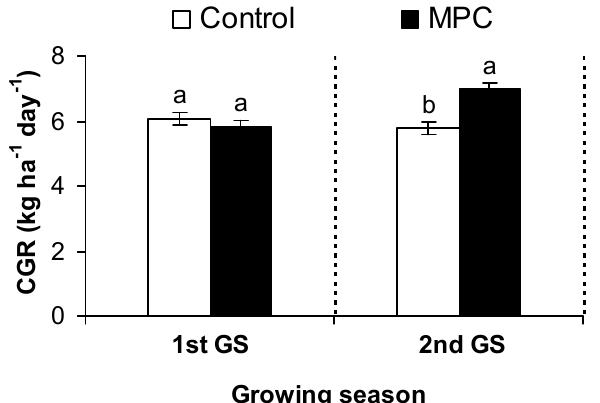
Figure 8. Crop growth rate (CGR) of sunflower plants as influenced by foliar treatments of MPC (37.5 + 37.5 g ha − 1 in the 1st growing season (GS) and 37.5 + 37.5 + 37.5 g ha − 1 in the 2nd GS). Different letters within each GS show statistically significant differences at p < 0.05 and vertical bars denote standard errors of means ( n = 12). MPC, mepiquat chloride.